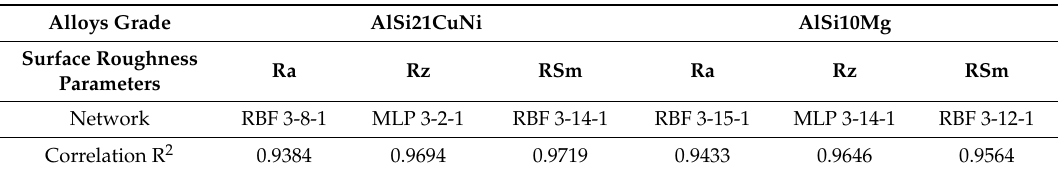
Figure 10. Numerical results after AWJ for AlSi21CuNi alloy for surface roughness parameters Ra (RBF 3-8-1) depending on the jet feed rate v f and abrasive flow rate m a ( a ), as well as depending on the jet feed rate v f and sample height h ( b ), and surface roughness parameters RSm (RBF 3-14-1) depending on the jet feed rate v f and abrasive flow rate m a ( c ), as well as depending on the jet feed rate v f and sample height h ( d ). Table 8. Correlation R 2 for surface roughness parameters Ra, Rz, and RSm for AlSi21CuNi and AlSi10Mg